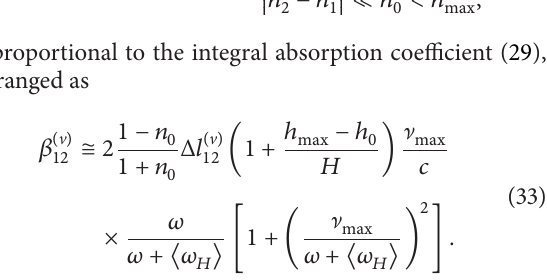
∘ ∘ Rome , Italy (41.89 , 12.49 ) and the receiver Chania , Crete (35.52 ∘ , 24.02 ∘ ) stations. The D-layer, represented by a com- plex eikonal model, covers a short range of heights between = 50 km and ℎ = 80 – 90 km, the absolute temperature ℎ 1 2 decreasing, respectively, from 𝑇 1 = 273 K to 𝑇 2 = 187 K